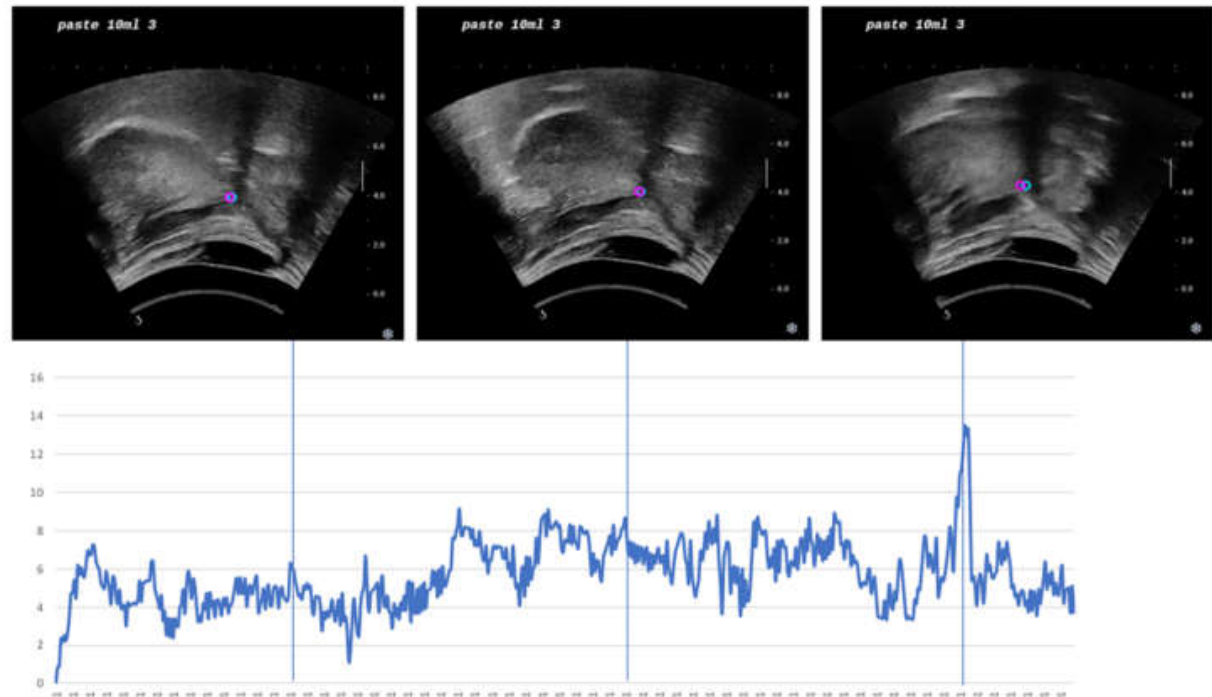
Figure 7. Performance plot. Center error of all frames from a test sequence in full-length where the female swallows 10 mL of paste liquid. The y -axis is a center error in pixel and the x -axis is frame number. Three example images from every 200 frames were chosen and displayed above the plot. The pink dot represents the center of inference, and the blue dot represents the center of ground truth (annotation).